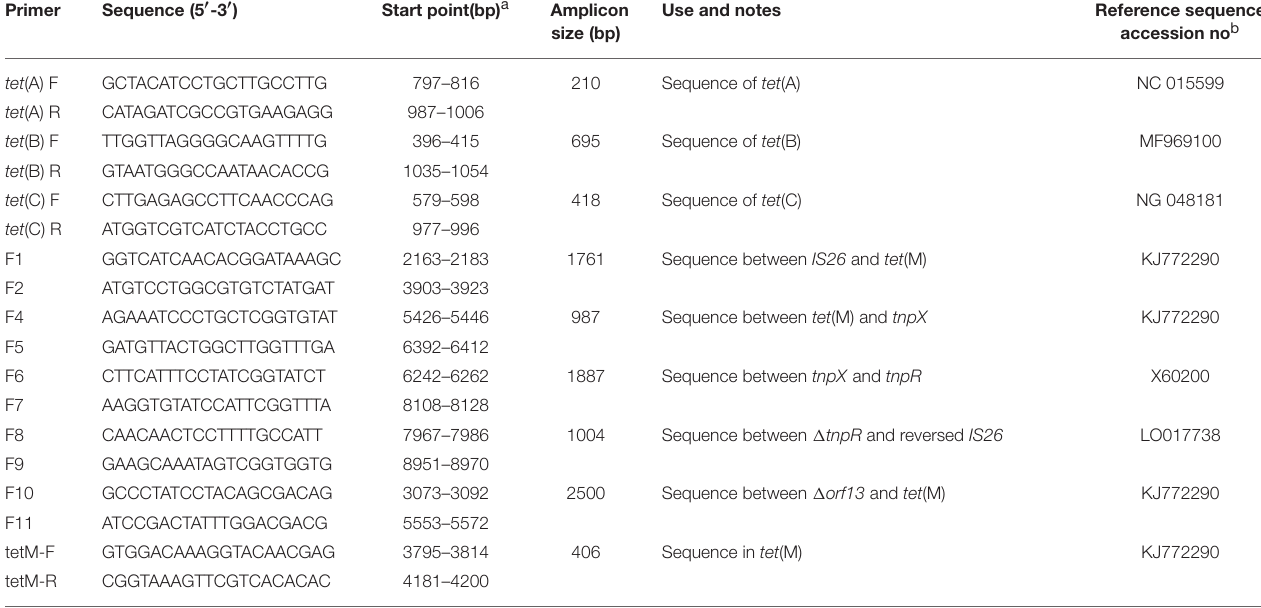
TABLE 2 | Primers used in this